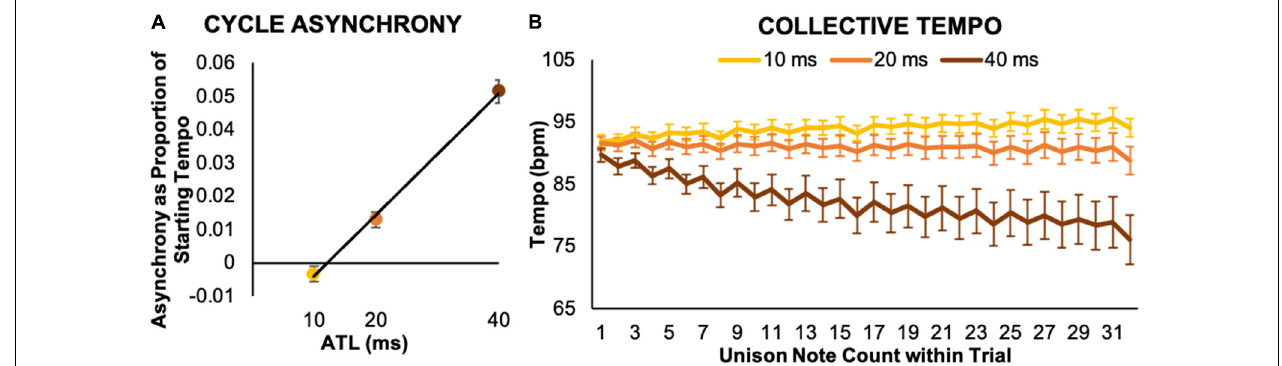
FIGURE 3 | Collective temporal behaviors. (A) Cycle asynchrony indicates how much lead or lag performers produced in one cycle of the collective rhythmic pattern, expressed as a ratio to the initial metronome tempo. It revealed that both performers’ keypress timing preceded each other’s keypress timing at the 10 ms ATL and then lagged each other’s behavior by increasing amounts at the longer 20 and 40 ms ATLs. (B) Collective tempo indicates the tempo estimated at each unison note position. Over the course of a trial performers sped up in the 10 ms ATL condition, maintained a consistent tempo in the 20 ms ATL condition, and got substantially slower in the 40 ms ATL condition. Error bars show standard